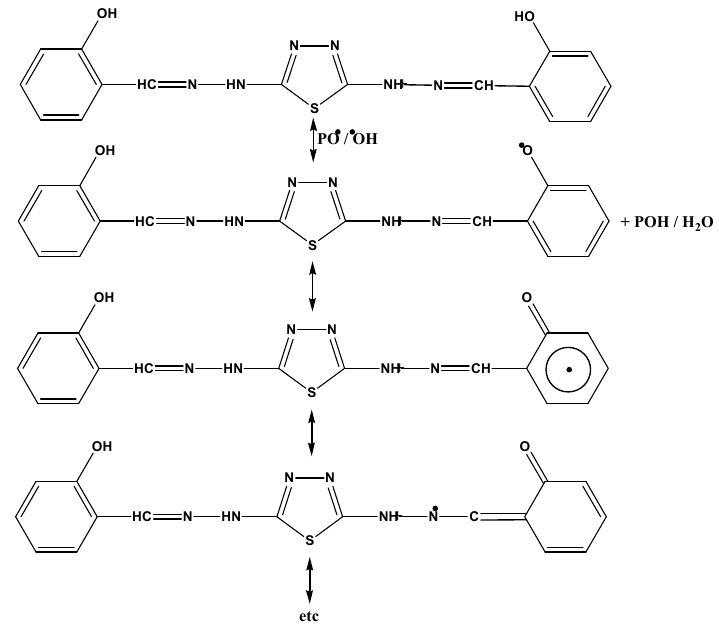
Scheme 6. The suggested mechanism of the photostabilization of PVC by the 2,5-di(2-hydroxyl phenyl hydrazone)-1,3,4-thiazole compound as a radical